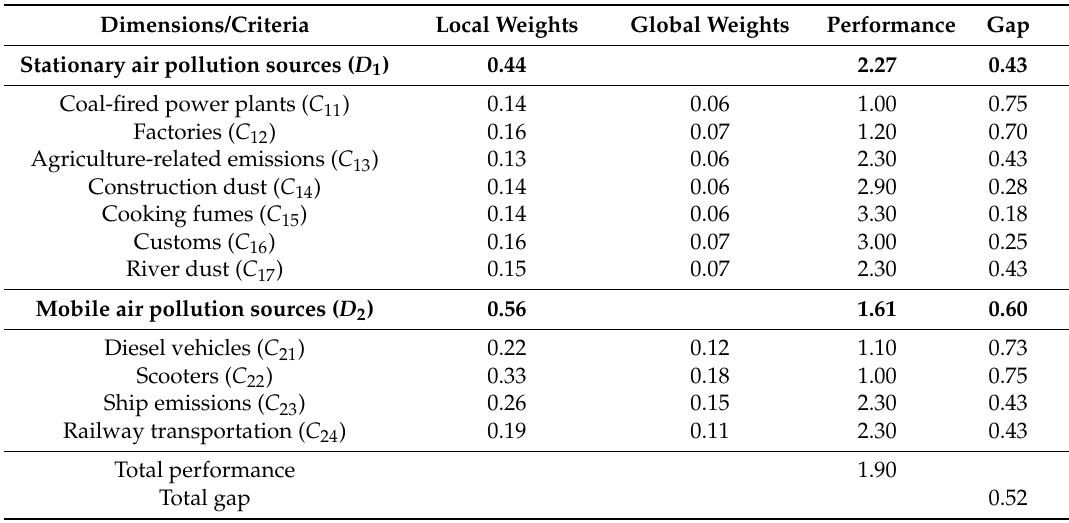
Table 3. Performance evaluation of the empirical case using modified Vlse Kriterijuska Optimizacija Komoromisno Resenje